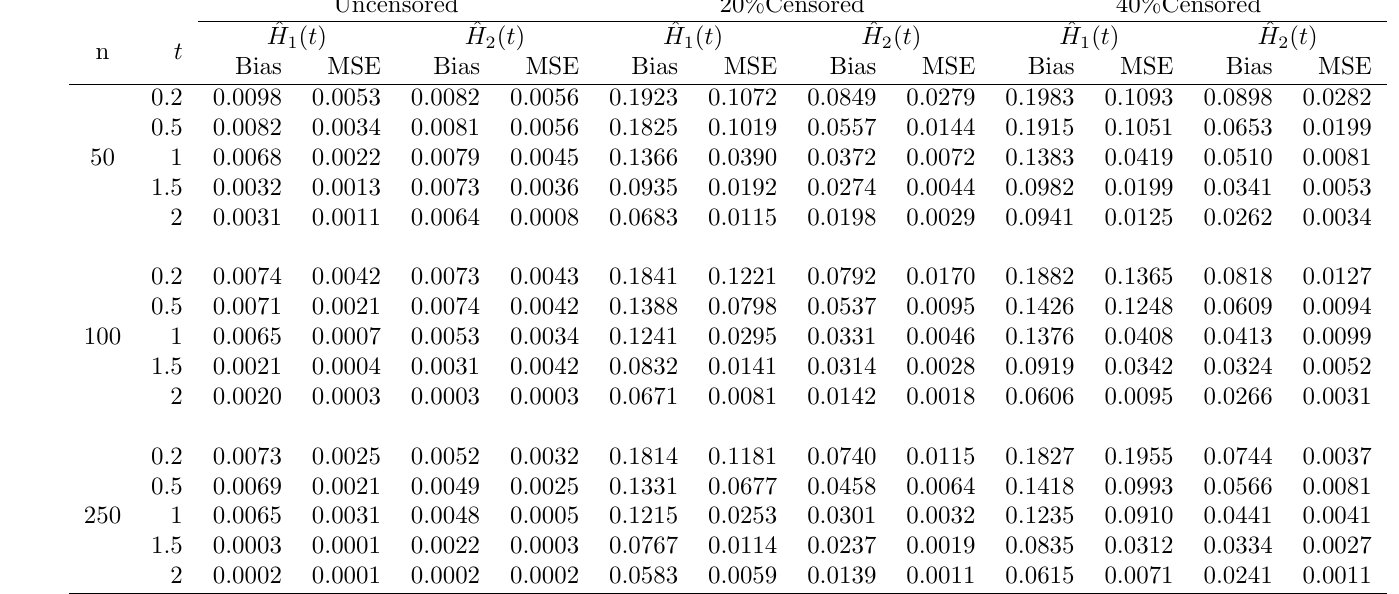
Bias and MSE of the estimates of H 1 ( t ) and H 2 ( t ) for a = 1 . 5 , ϕ = 0 . 2 and λ = 0 .